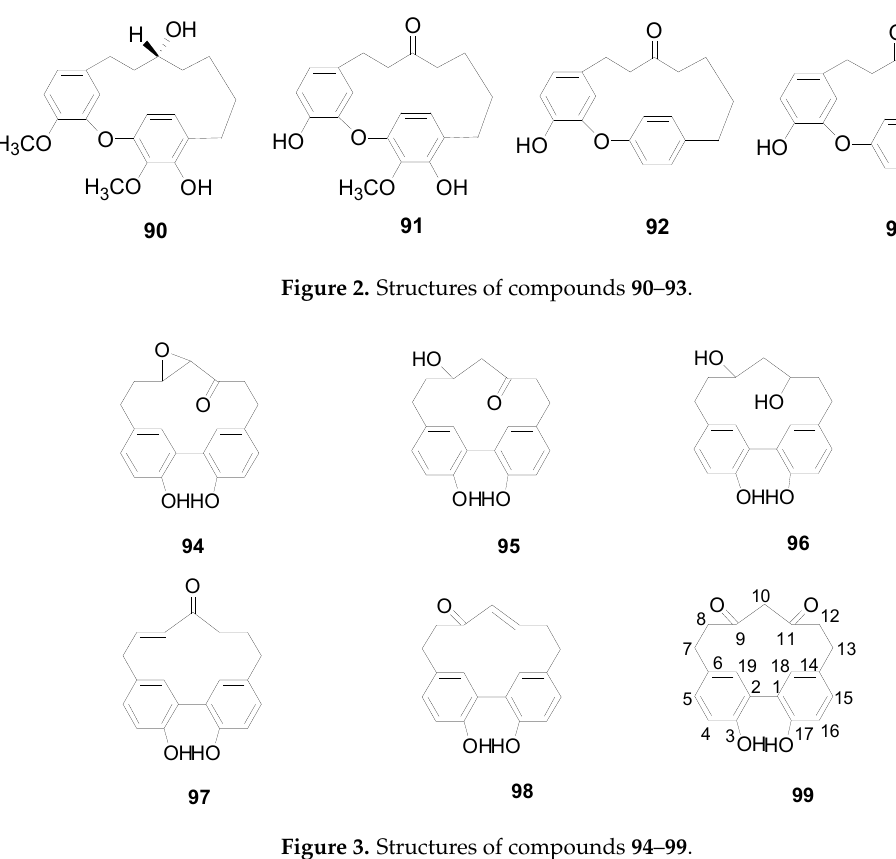
Figure 3. Structures of compounds 94 – 99 .